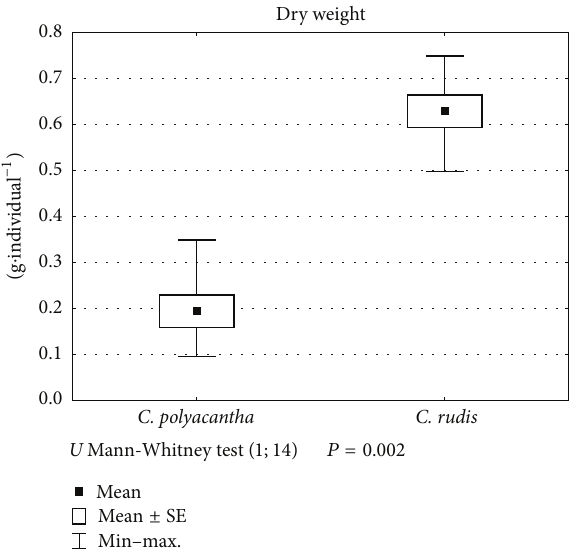
Figure 5: The differentiation between C. polyacantha and C. rudis against dry weight.